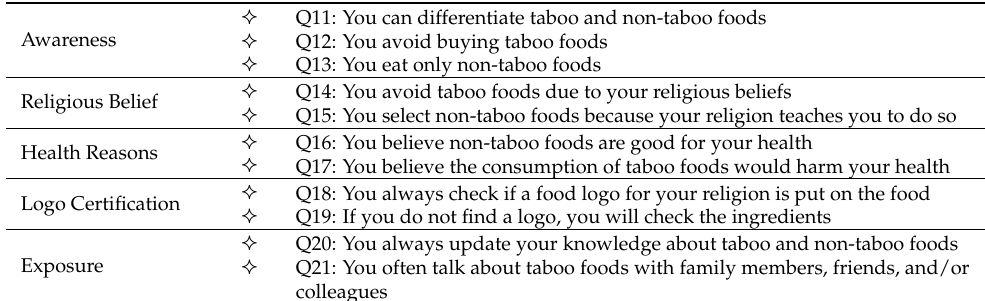
Table 2. Questions on the religious restrictions on foods.